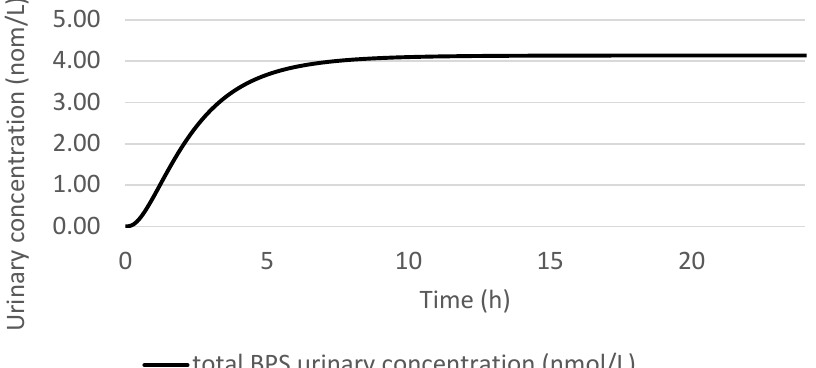
Figure 3. Estimated total urinary BPS concentration (nmol/L) for a 70 kg adult after 24 h constant and continuous oral exposure to 0.0266 µ g of BPS/kg bw averaged over 24 h in the general population. For workers, the same approach of using the POD and modified PBPK model by Karrer et al. (2018) was used to derive the HBM-GV worker . Applying an assessment factor of 75 (3 × 2.5 × 10) and assuming a constant and continuous oral exposure of BPS through- out the day would lead to a constant exposure of 0.0266 µ g/kg bw/day. However, as occupational exposure is not continuous throughout the day or week, the modelling was refined in order to reflect a continuous exposure of 8 h per day followed by a non-exposure period of 16 h. This 8 h exposure and 16 h non-exposure period was then repeated four times in order to mimic a working week. Thus, this 5 day occupational scenario includes an 8 h exposure period with 0.0798 µ g/kg bw and a non-exposure period of 16 h which then corresponds to an exposure for the entire day (0–24 h) of 0.0266 µg/kg bw/day (Figures 4 and 5). The estimated concentration of total BPS (sum of estimated urinary BPS- G and free BPS) in urine is 12.1 nmol/L (3028 ng/L). The HBM-GV worker is then rounded to 3.0 µg/L.